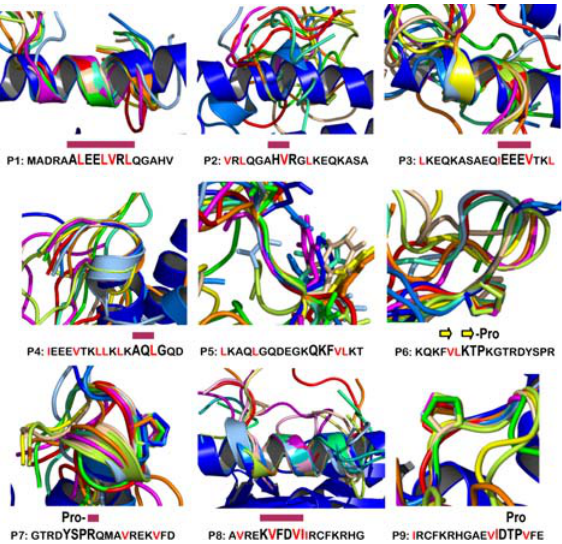
Figure 4. Molecular dynamics simulations of HRS-derived peptides. Three-dimensional conformations of individual 18 amino acid HRS peptides (presented in Figure 1) were simulated for 10 nanoseconds. Each simulation consists of 10 snapshots (from light blue to red) separated by 1 nanosecond intervals and superimposed on a structure matching the corresponding motif present in full protein (shown here in blue, but also depicted in Figure 1). Peptide sequence is again shown below respective simulations, with hydrophobic residues in red and conserved regions in a larger font. Structural motifs for each conserved region are designated by the following symbols: red bars=helices, yellow arrows= b -sheets, and Pro=proline residues. For peptide 5 (P5), Gln 12 and Phe 14 are shown as sticks (in the figure) to indicate that the conserved backbone is blocked by flanking side chains.